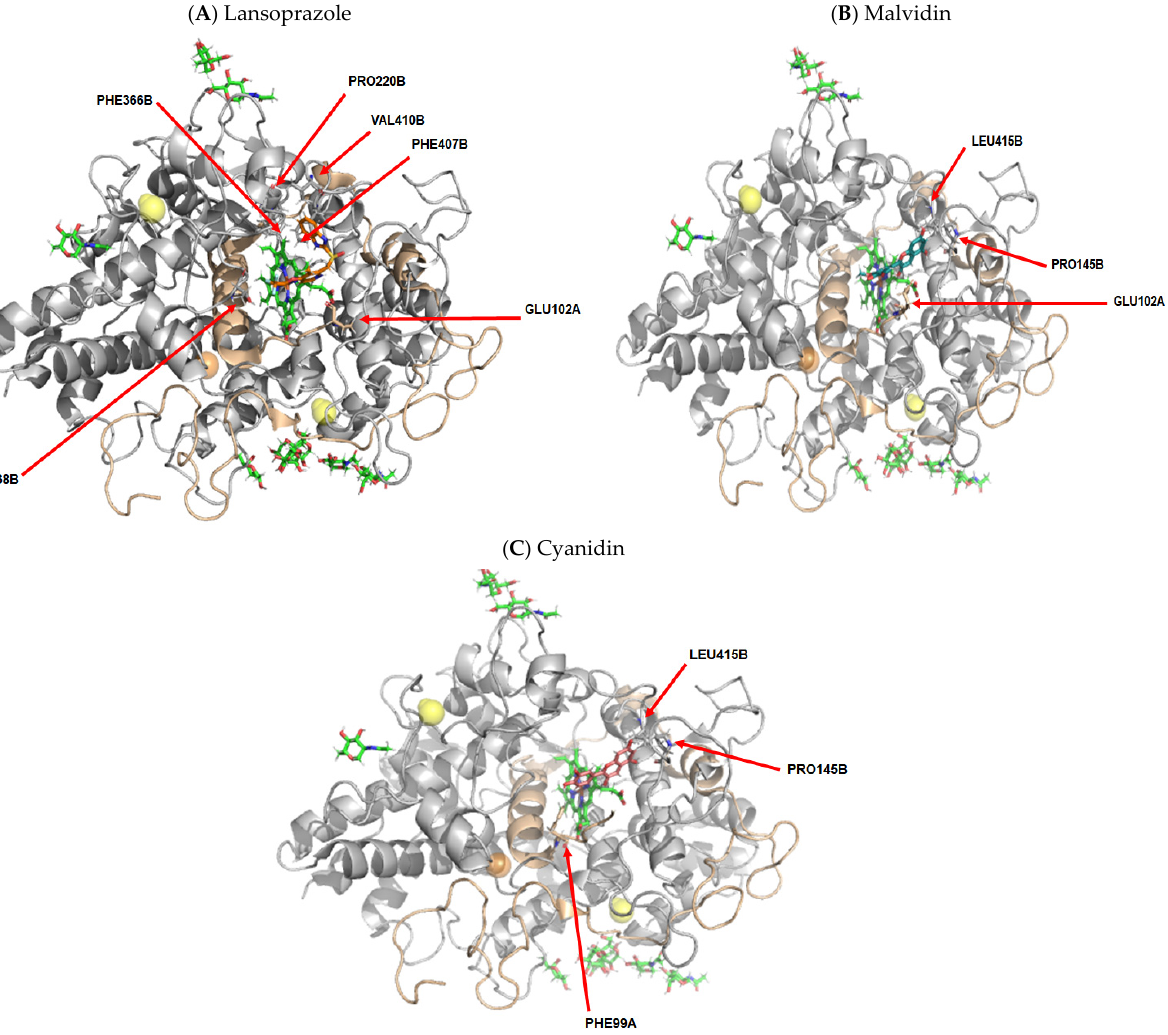
Figure 14. Molecular coupling of the lansoprazole ( A ), malvidin ( B ) and cyanidin ( C ) molecules on Myeloperoxidase (MPO) protein–PDB 7LAE, docking chain A and B. ( A ) Lansoprazole : Best pose with − 7.5 kcal/mol (affinity energy). FAD and glycerol molecules shown colored in green. Mn 2+ and Cl - ion are shown colored in orange and yellow ball, respectively. Lansoprazole molecule colored in orange. ( B ) Malvidin : Best pose with − 7.0 kcal/mol (affinity energy). FAD and glycerol molecules shown colored in green. Mn 2+ and Cl - ion are shown colored in orange and yellow ball, respectively. Malvidin molecule colored in bluish-green. ( C ) Cyanidin: Best pose with − 7.6 kcal/mol (affinity energy). FAD and glycerol molecules shown colored in green. Mn 2+ and Cl - ion are shown colored in orange and yellow ball, respectively. Cyanidin molecule colored in pink.